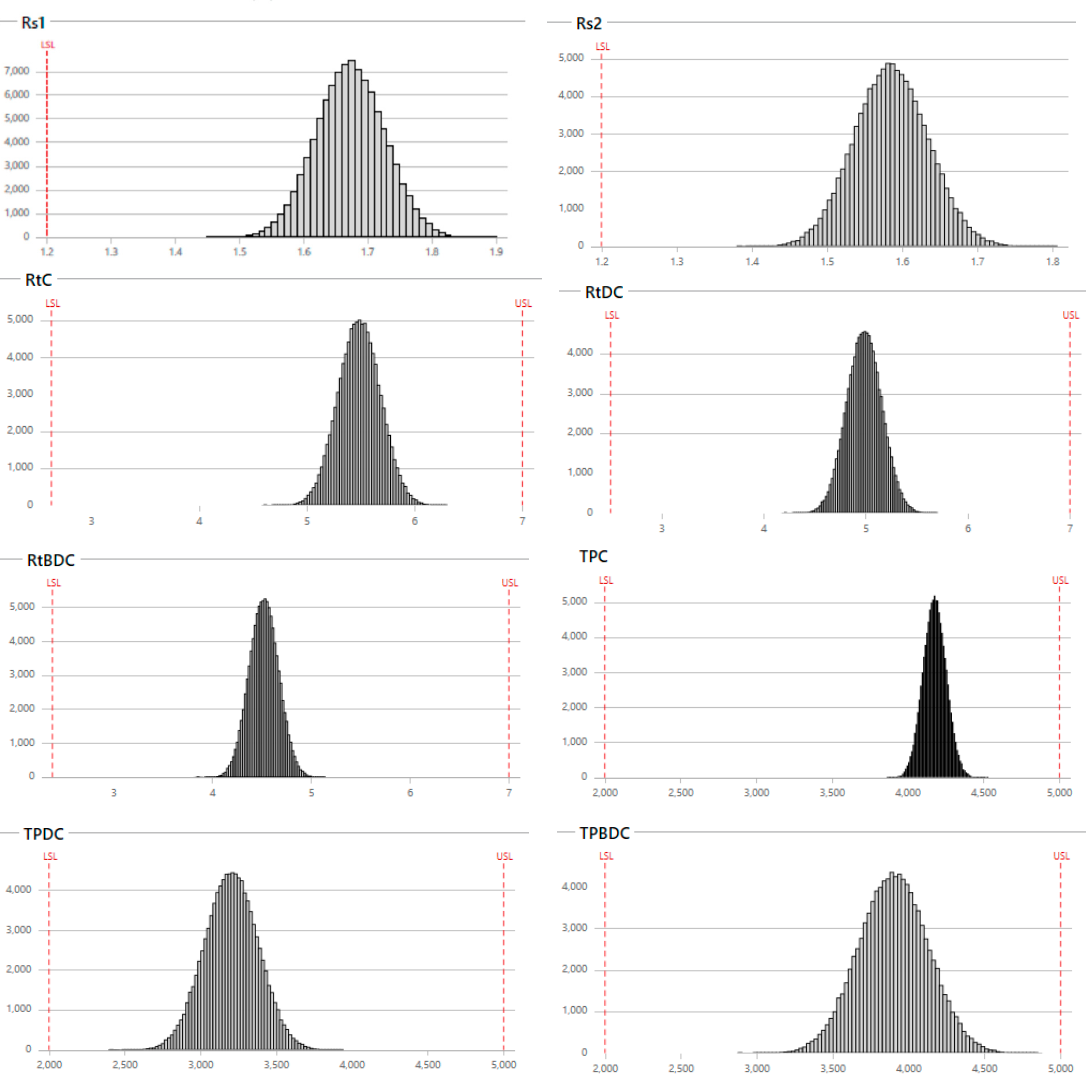
Figure 5. Monte Carlo simulation histograms of CMAs, and Cpk values with upper (right side row), and lower (left side row) specifications limits. The resolutions (Rs), retention time (RT), and theoretical plates (TP) were simulated for the curcumin (C), bisdemethoxycurcumin (BD), and desmethoxycurcumin